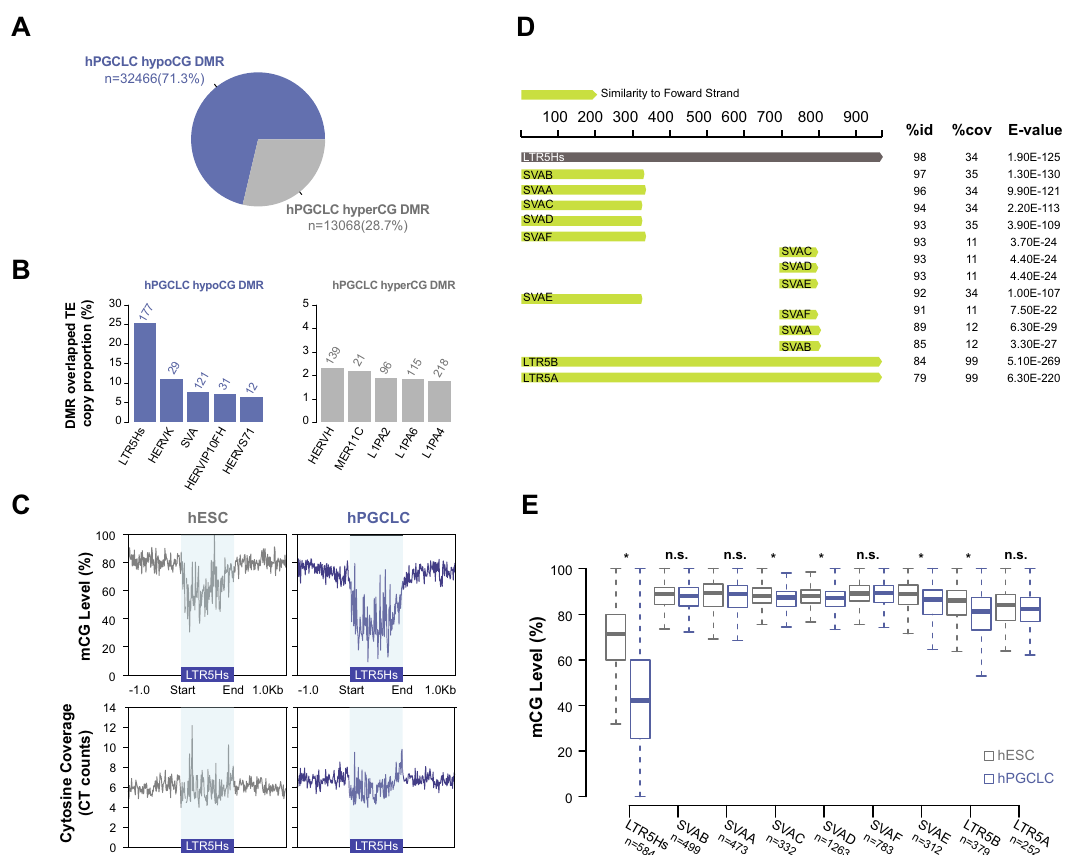
Fig. 3 Localized DNA demethylation over LTR5Hs in hPGCLCs. A Percentage of hypoCG and hyperCG DMRs in hPGCLCs compared to hESCs. B Bar plot showing enrichment of TE subfamilies in hyperCG or hypoCG DMRs as a proportion of total TE copy number. C Metaplot of aggregate CG methylation level (top) and cytosine coverage (bottom) over LTR5Hs in hESCs and hPGCLCs. Blue shaded rectangle region indicates annotated LTR5Hs regions. D The consensus sequence similarity of LTR5Hs and related TE clades from Dfam 45 . Percent identity between the entry consensus sequences (%id), percent shared coverage (%cov) and match e-value (E-value) are displayed on the right. E Boxplot of CG methylation level over LTR5Hs and related TE clades in hESCs and hPGCLCs. Only TE subfamilies with a copy number >100 are included in the plot. * p -value < 0.05, Welch Two Sample t -test; n.s. represents not signi fi cant. The middle line represents the median; boxes represent the 25th (bottom) and 75th (top) percentiles; and whisker bars represent the minimum and maximum points within the 1.5× interquartile range. Source data underlying E is provided as a Source Data fi le and originates from n = 2 biological replicates (separate experiments) of hESCs and hPGCLCs generated from the UCLA2 hESC